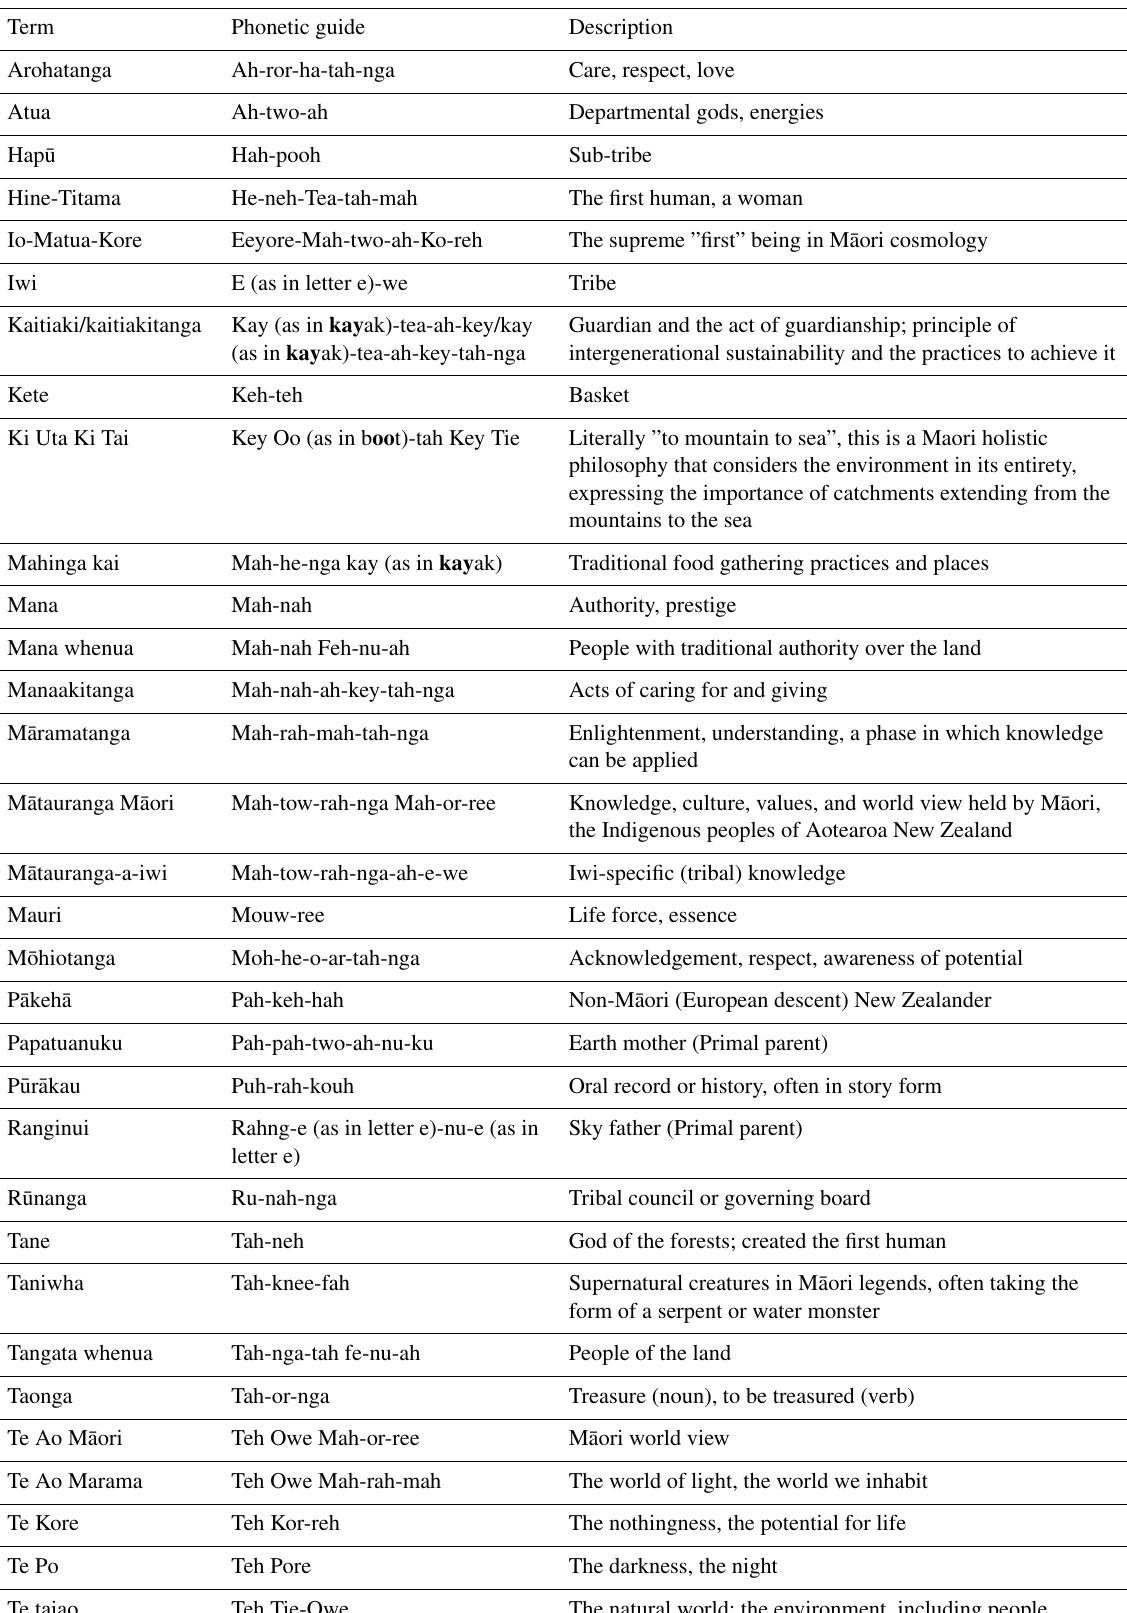
Table 1. Glossary of M¯aori terms (as used in this paper).